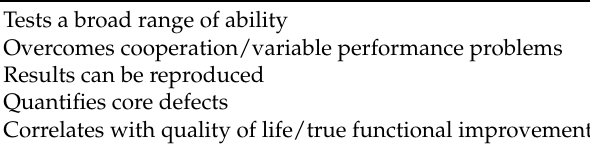
Table 3. Desirable clinical outcome measure attributes